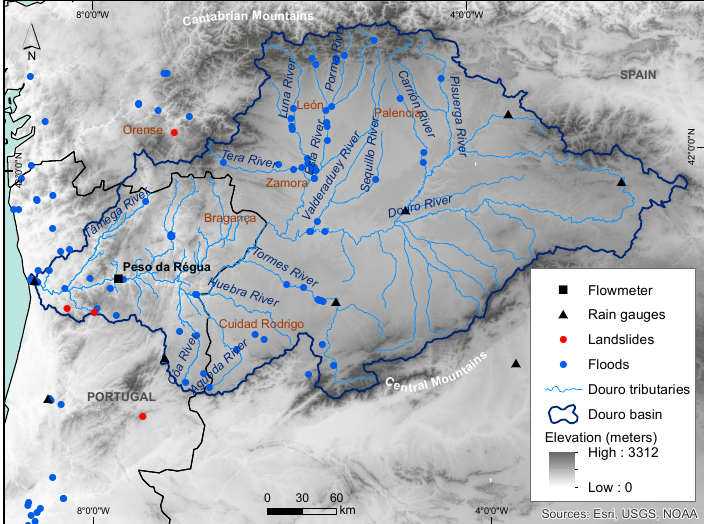
Figure 4. Douro Basin and DISASTER cases of the December 1909